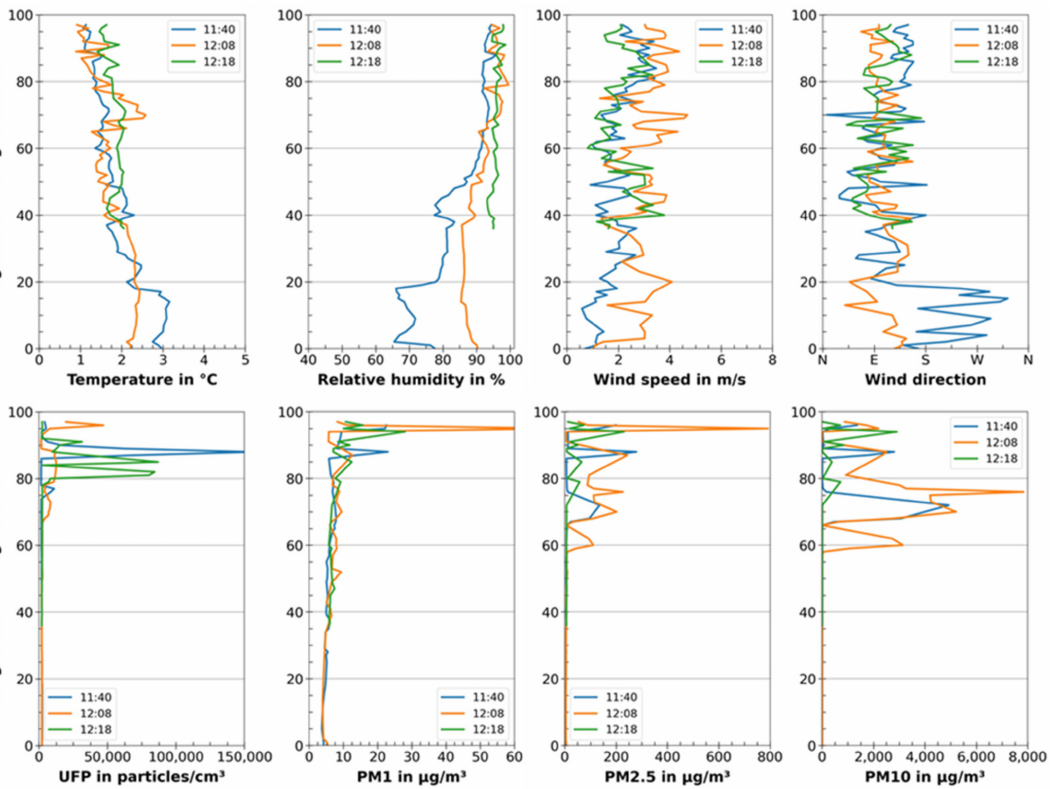
Figure 6. Vertical profiles of the meteorological parameters and air pollutants during the field test (ascents) on 31 January 2021.